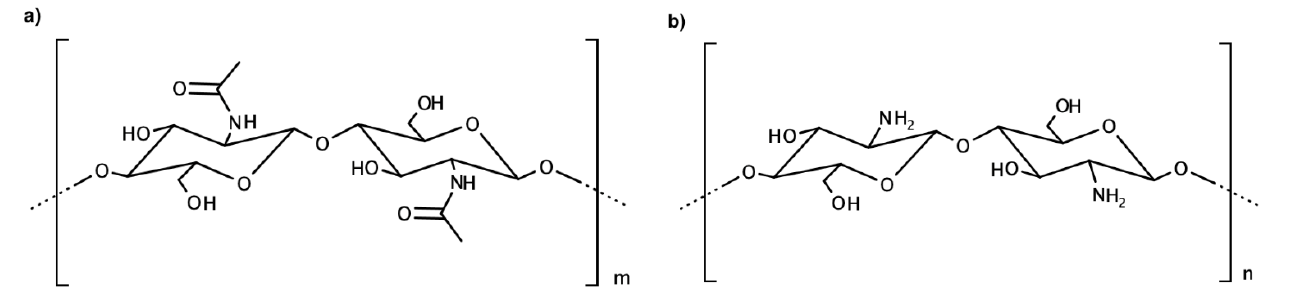
Figure 5. ( a ) Chitin and ( b ) Chitosan structures. (Adapted with permission from [16], Copiright 2020, ACS). Xin et al. [17] developed a voltammetric chitosan-modified glassy carbon electrode for bromide detection in acid solutions (Figure 6).